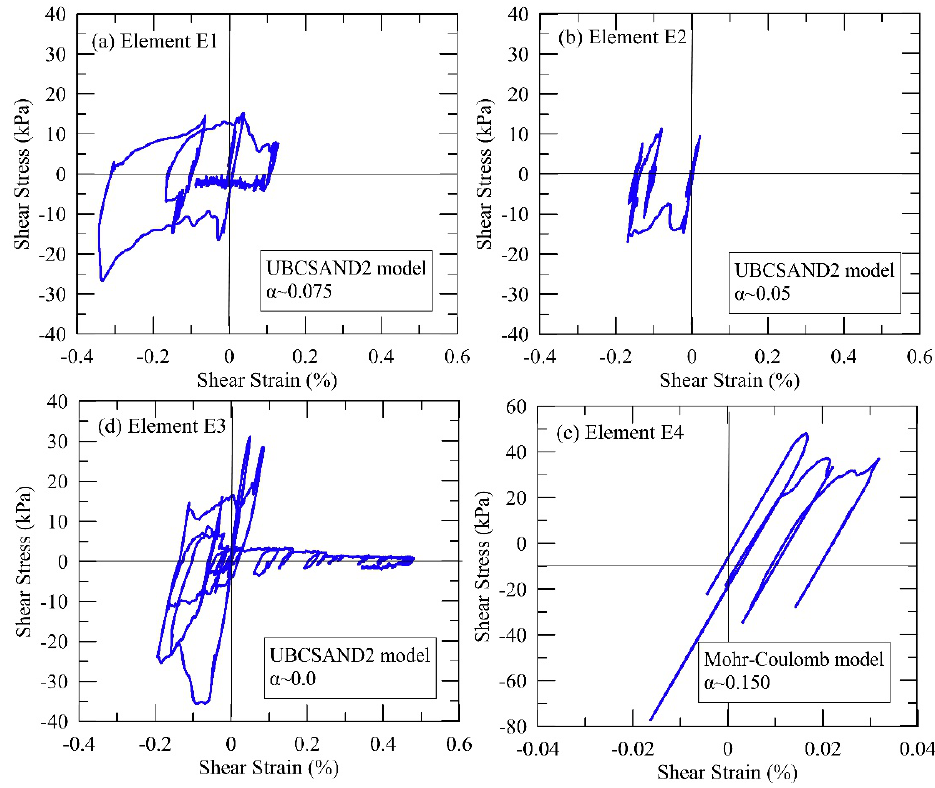
Figure 23. Shear stress–strain relationship of the observed elements in the analysis: (a) element E1, (b) element E2, (c) element E3, and (d) element E4.